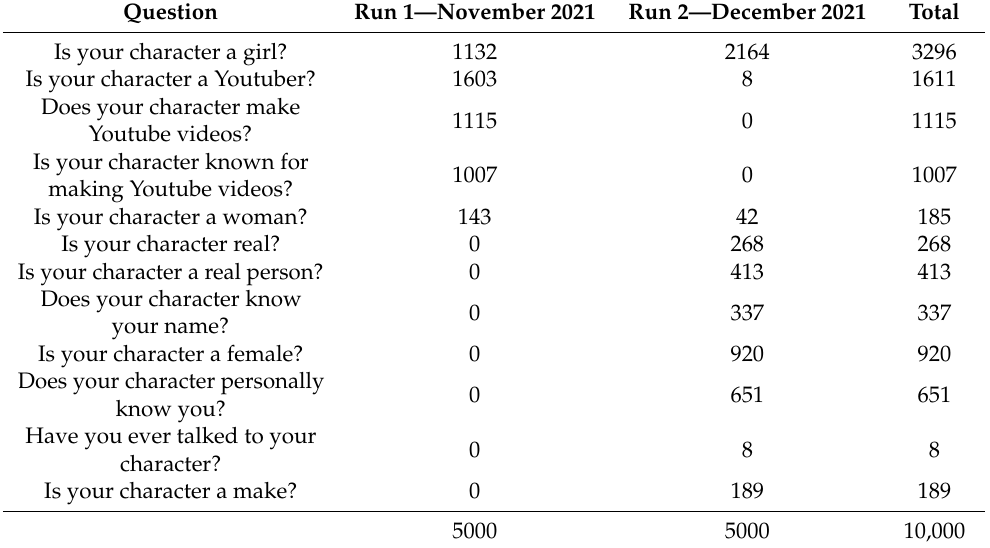
Figure 1. ( Top panel ) The number of new distinct questions found through 300 games played with a constant answer (‘yes’, ‘no’ or ‘probably’). This number consistently decreases as more games are played, until only a few new questions are found with every new game. ( Bottom panel ) The top 20 most frequent questions in 4000 games. The games were played with constant answers throughout the whole game, so that each of the five possible answers (‘yes’, ‘no’, ‘I don’t know’, ‘probably’ and ‘probably not’) was used in 800 of the games. Table 1. Questions that were asked as first questions in games and the number of times they appeared in each of the two runs. Clearly, the set of questions changed over